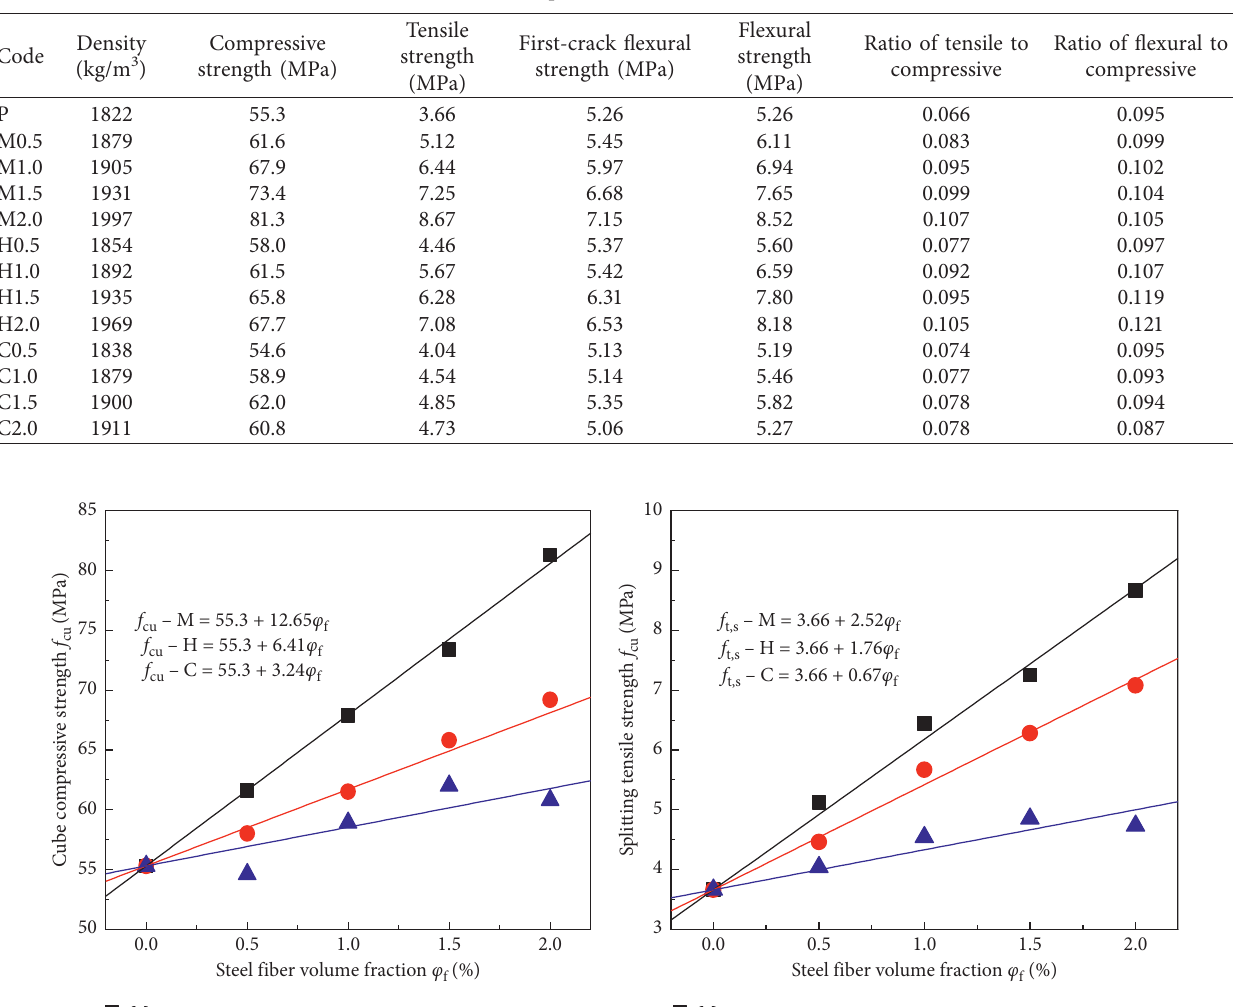
Figure 3: Bending toughness test device. Table 4: Mechanical performance test results of HSLAC.